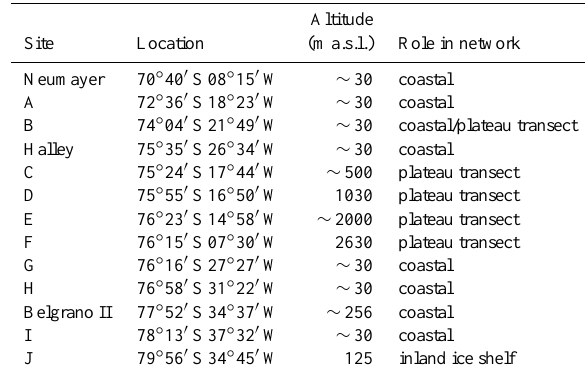
Fig. 1. (a) Map of study area showing both the autonomous sites (Sites A to J) and the manned stations (Neumayer, Halley and Belgrano II) contributing to the network; (b) AMSR-E map of sea ice extent and concentration for 7 October 2008. 568 temporarily switched off to allow the batteries to recharge. Table 1. Details of all ozone monitoring sites discussed in this pa-